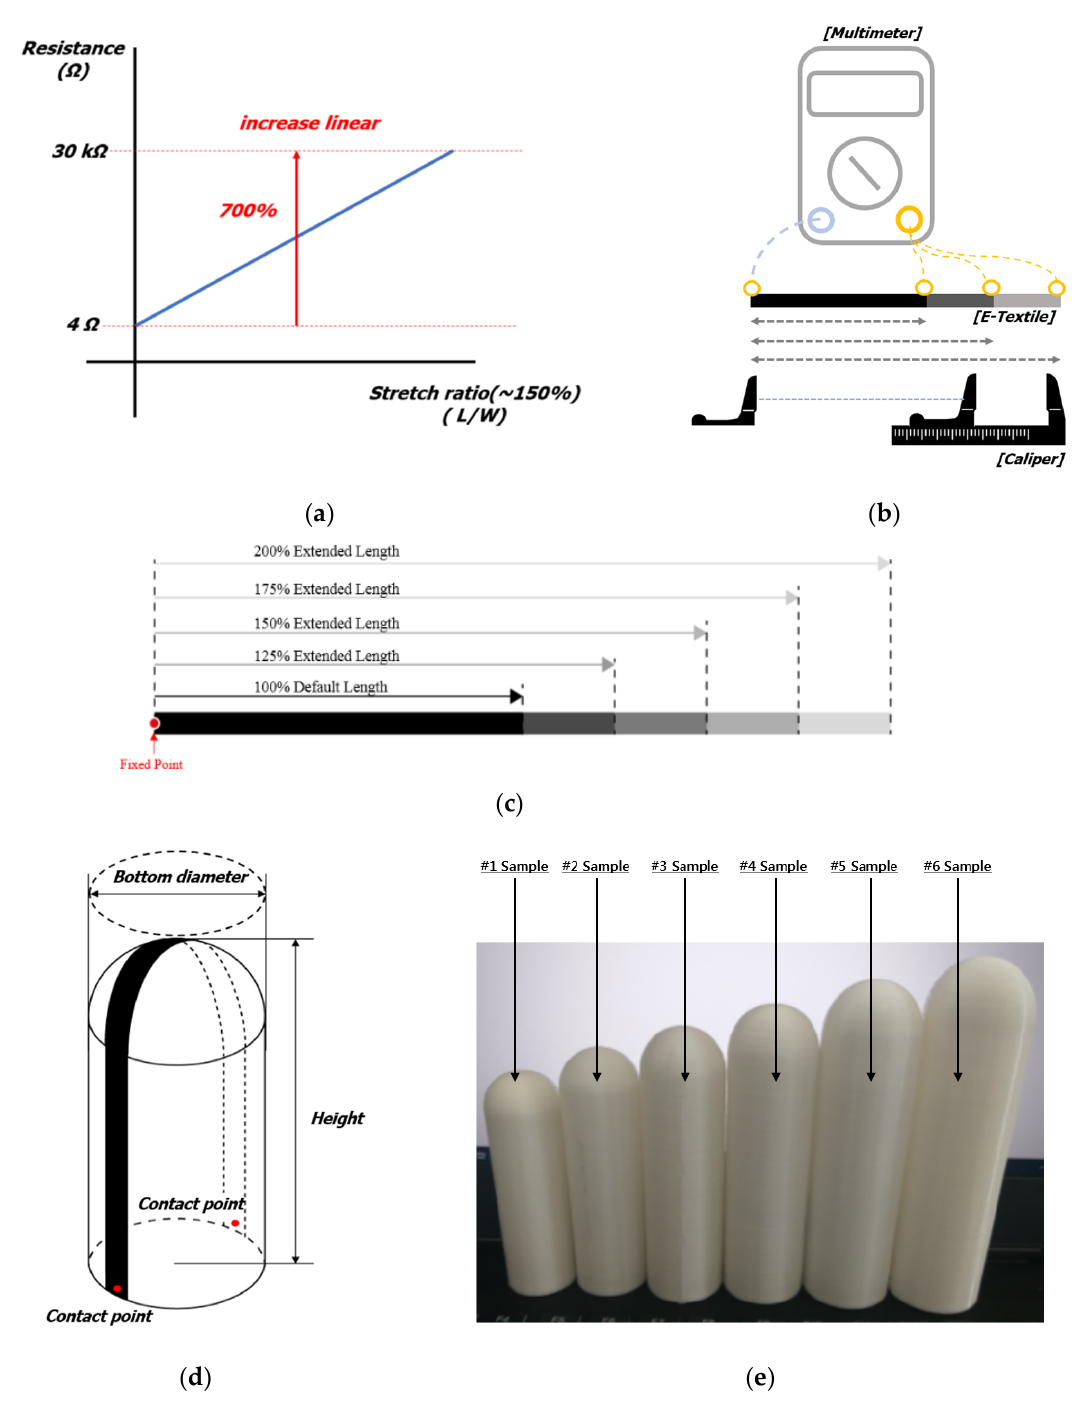
( c ) Figure 5. Resistant Fiber Sensor Read-out Wireless Communication Module: ( a ) Sensor module sys- tem block diagram (data transmission unit); ( b ) Communication module PCB design; ( c ) Read-out Wireless Communication Module. 3. Results 3.1. Wearable E-Textile Sensor Figure 6 shows the change in resistance according to the E-textile stretch ratio. In